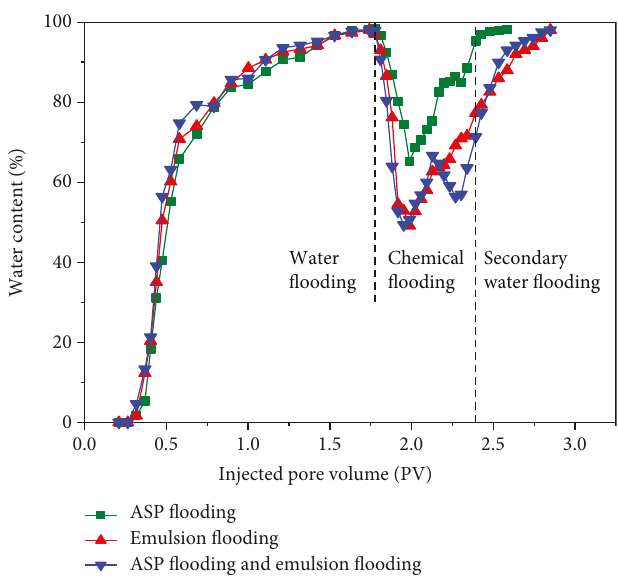
Figure 11: Total recovery variation curve of di ff erent chemical fl